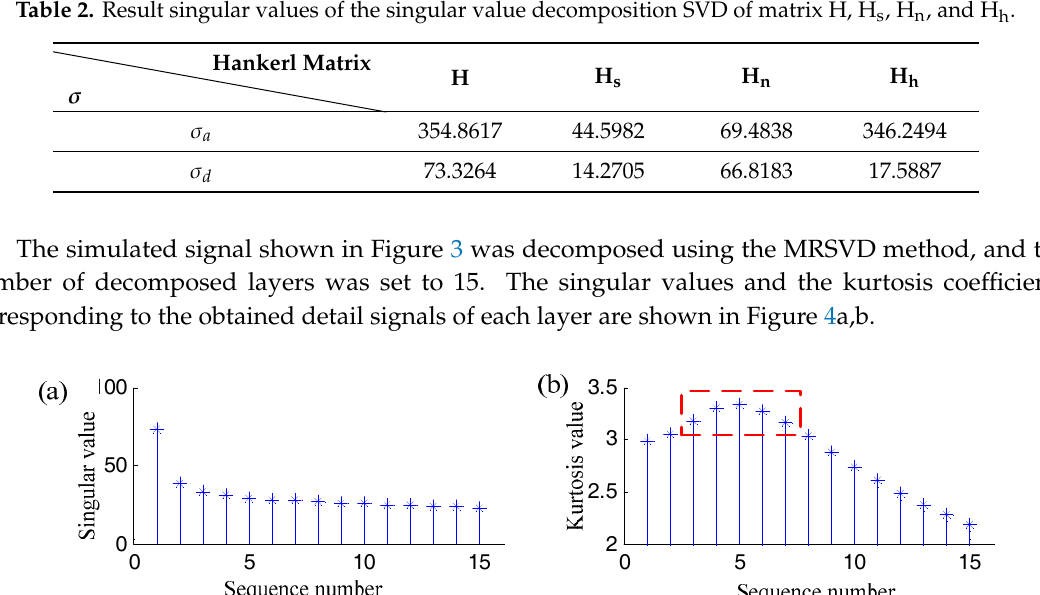
Table 2. Result singular values of the singular value decomposition SVD of matrix H, H s , H n , and H h.